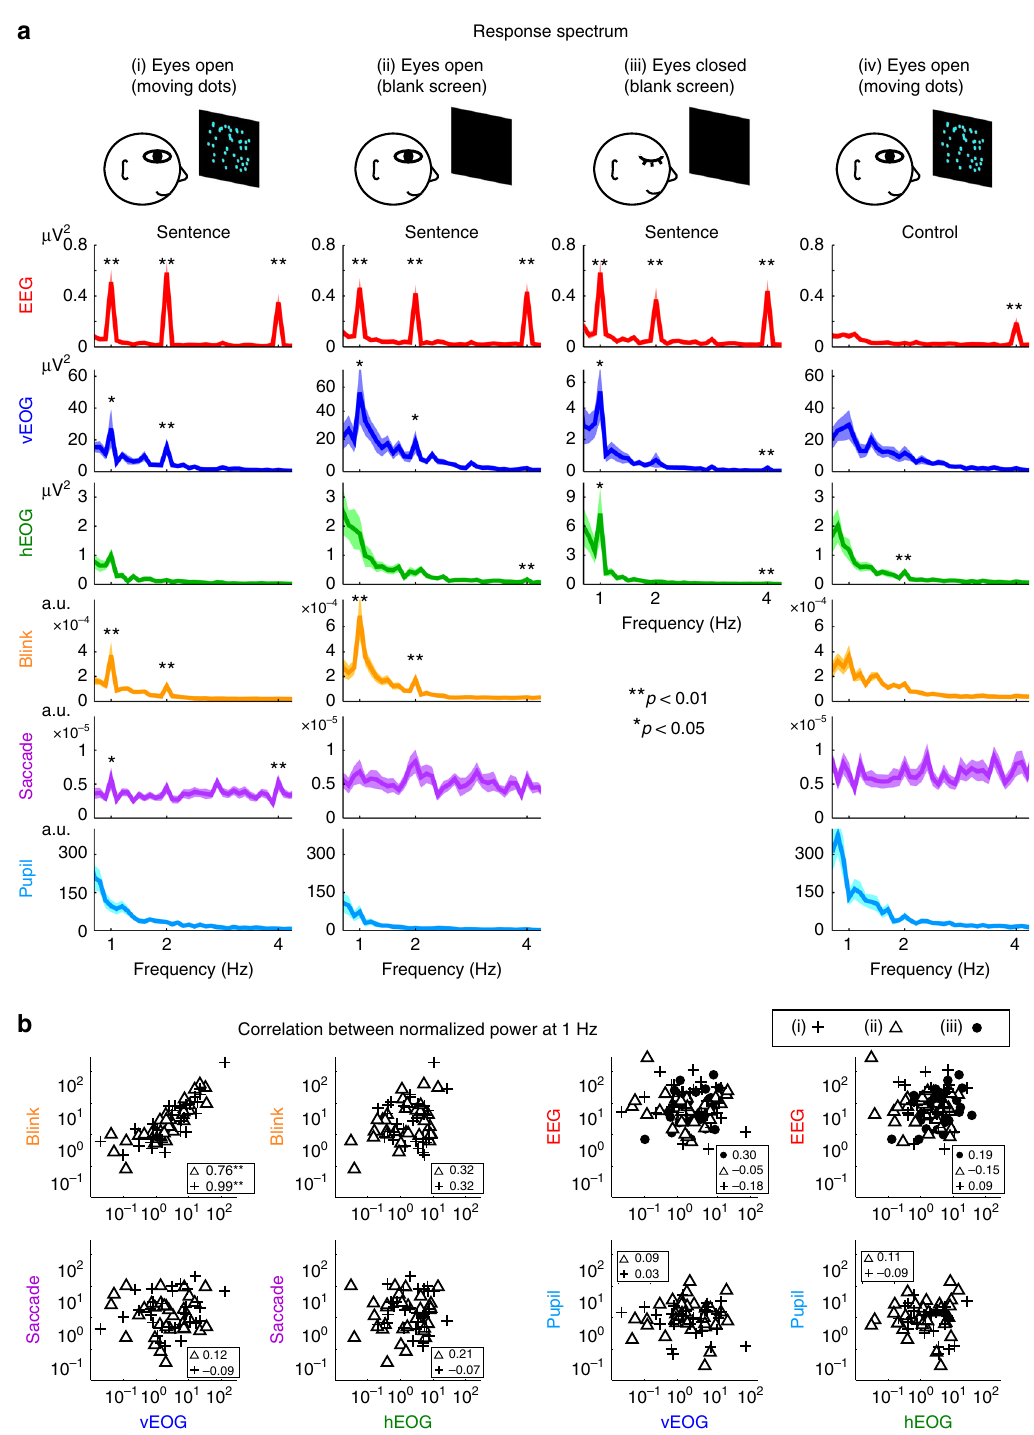
Fig. 2 EEG, EOG, and eyetracking responses to sentences or random syllables. a Response spectra in four experimental conditions (columns) and for six neural/ocular measures (rows). The control condition presents random syllables instead of sentences. The blink rate measured by eyetracking, but not the saccade rate or pupil size, shows a reliable spectral peak at 1 Hz across conditions. The EEG signal is from channel Cz. Signi fi cance of each spectral peak is evaluated using bootstrap. The shaded area covers 1 SEM across participants ( N = 32) on each side. b The 1-Hz blink response is correlated with the 1-Hz vertical EOG response. In contrast, the 1-Hz components of other measures are not signi fi cantly correlated. Each dot is one participant. For all signi fi cance tests in the fi gure, the P -value, mean, and SEM are reported in Supplementary Table